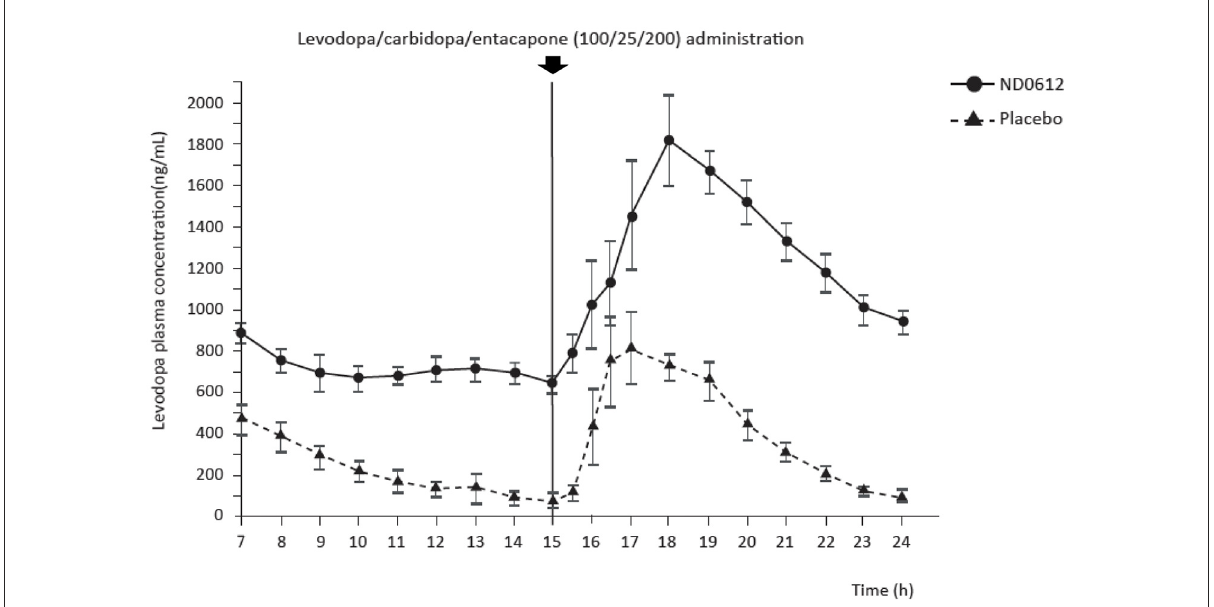
FIGURE2 Mean levodopa concentrations over time in patients with Parkinson’s disease. Blood sampling began at 7h post-infusion start. Oral levodopa/carbidopa/entacapone (100/25/200) was taken at 3- and 15-h post-infusion start.